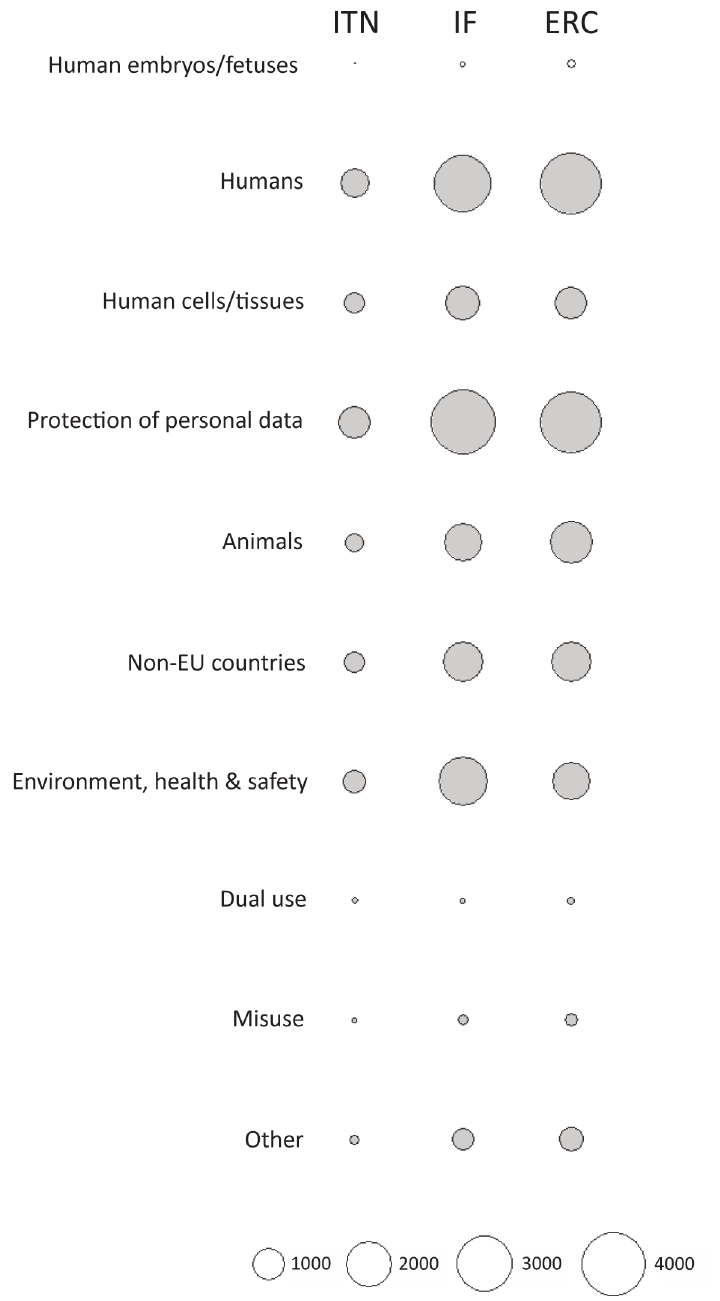
Figure 8. Ethics requirements identified by ethics experts, by ethics category. ITN – Innovative Training Networks, IF – Individual Fellowships, ERC – European Research Council grants. The data are from years available in the SEP tool of the European